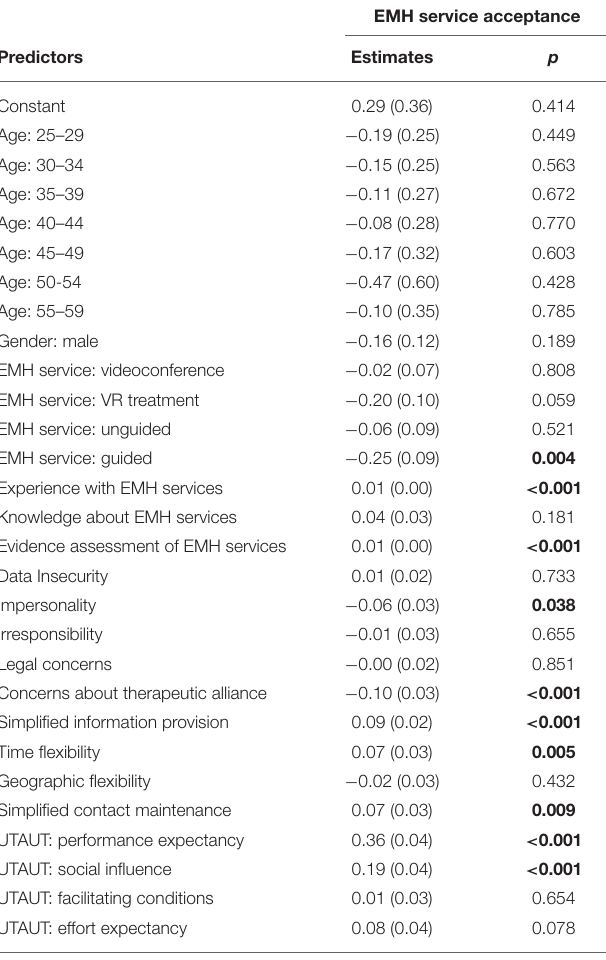
TABLE 5 | Estimates of EMH service acceptance determinants (advanced UTAUT